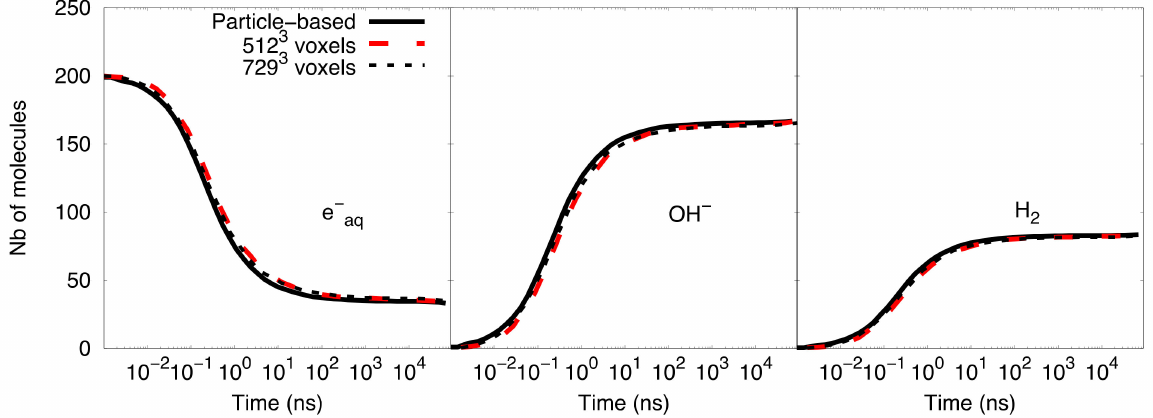
Figure 5. Comparison of species yield between the compartment-based model (the initial mesh of 729 3 voxels and the initial mesh of 512 3 voxels) and the particle-based SBS